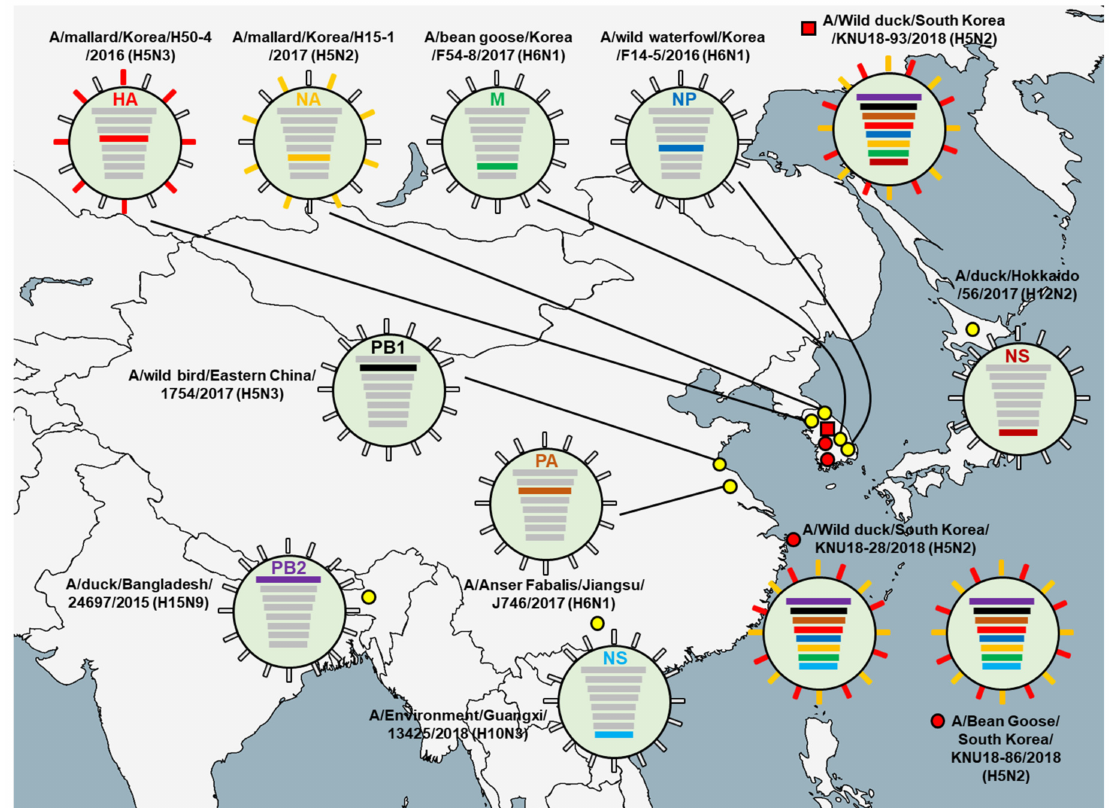
Figure 1. Putative origins of the genes comprising the KNU18-28 (A/Wild duck/South Korea/KNU18-28/2018 (H5N2)), KNU18-86 (A/Bean Goose/South Korea/KNU18-86/2018 (H5N2)), and KNU18-93 (A/Wild duck/South Korea/KNU18- 93/2018 (H5N2))